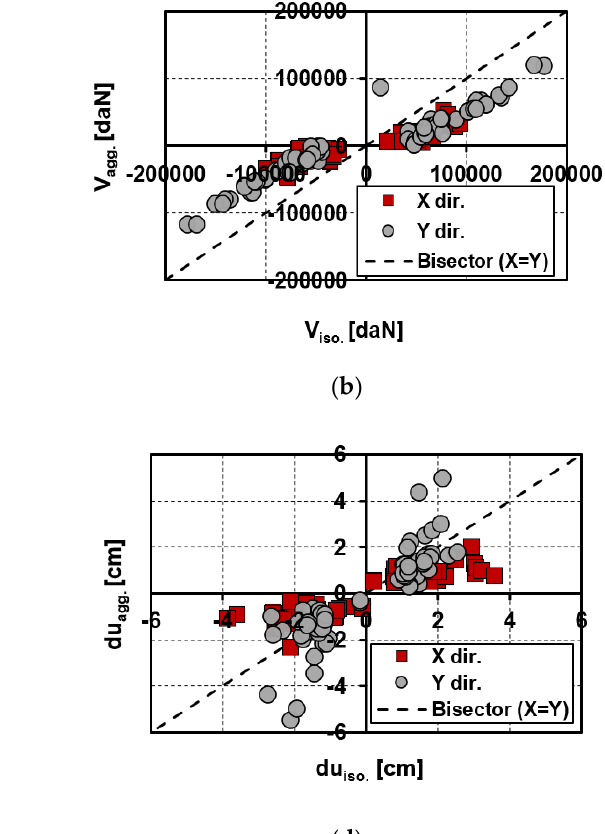
11 of 25 Figure 7. Capacity curves in X ( a ) and Y ( b ) directions for each SU in aggregate and isolated conditions. From a careful analysis of the results, it is possible to notice how the global behavior of the structure in both configurations, namely aggregate and isolated, showed a capacity variability in the two analysis directions. In particular, in the longitudinal direction (X- direction), an average increment of 48% was noted for SUs placed in aggregate configura- tions in comparison to the isolated ones. Furthermore, in terms of displacement ductility, a decrease of 55% was obtained in the aggregate configuration since, in this case, the con- finement effect offered by the contiguous structural units on the reference one limits the expected displacements compared to the isolated cases. However, this limitation also de- pends on the torsional phenomena, which are more critical for the external structural cells. The torsional effects arose from the addition of aliquots of structural mass passing from